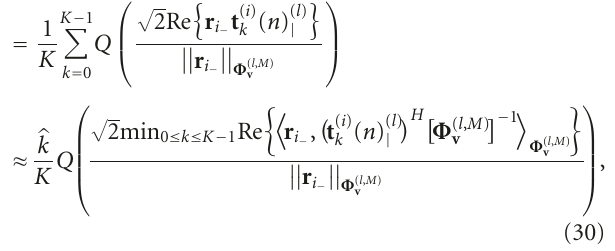
Algorithm 1. The whole system can be optimized